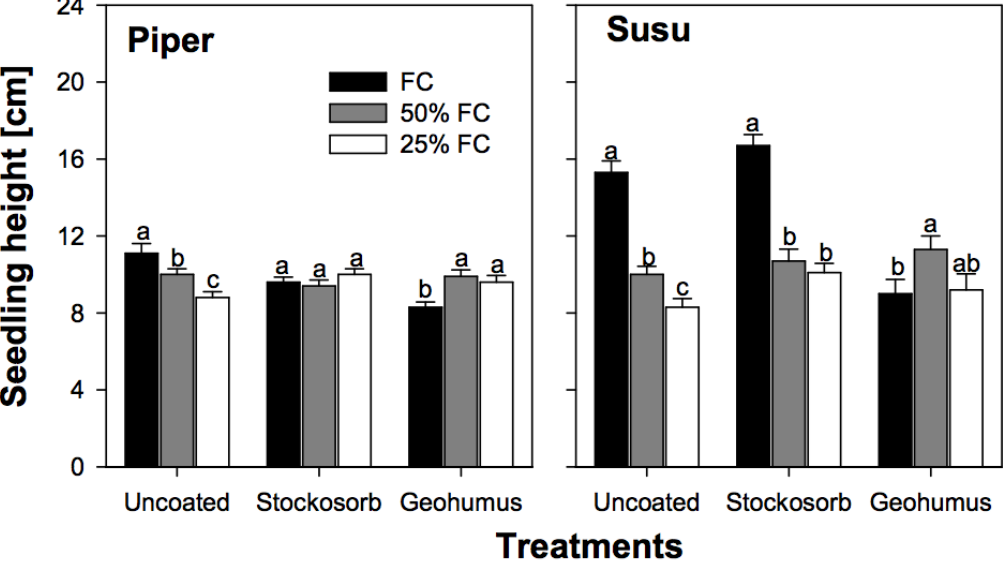
Figure 4. A comparison of the effect of drought stress on the height of coated and uncoated Piper and Susu seedlings assessed on the tenth day after sowing. (FC denotes soil moisture content at field capacity, bars indicated standard error of the mean and letters on bars are a comparison between the different moisture levels for the same treatment).